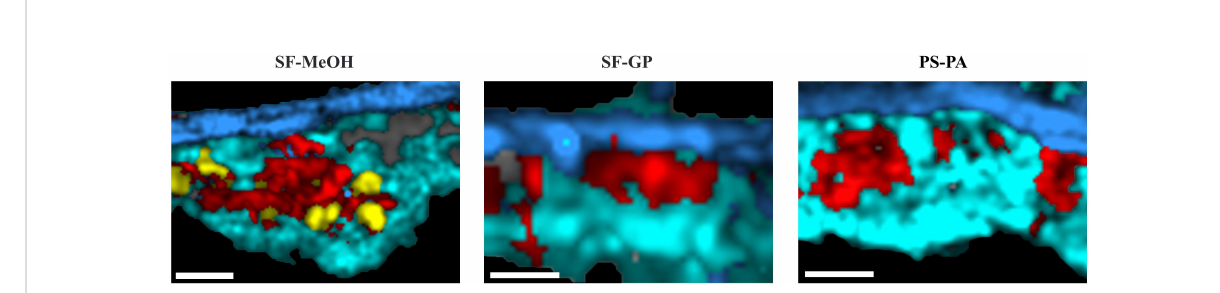
FIGURE 2 Comparative analysis of Raman imaging maps of the gills preserved using different methods. Raman imaging of the gills showing the distribution of cellular components, including the nucleus (red), cytoplasm containing symbionts (cyan), basal membrane (blue) and lysosome (yellow). The gray part is composed of feature spectrum of the slides, which is caused by the slight breakage of the tissue. Scale bars: 8 µm. The bright fi eld corresponding to Raman imaging images were shown in Supplementary Figure